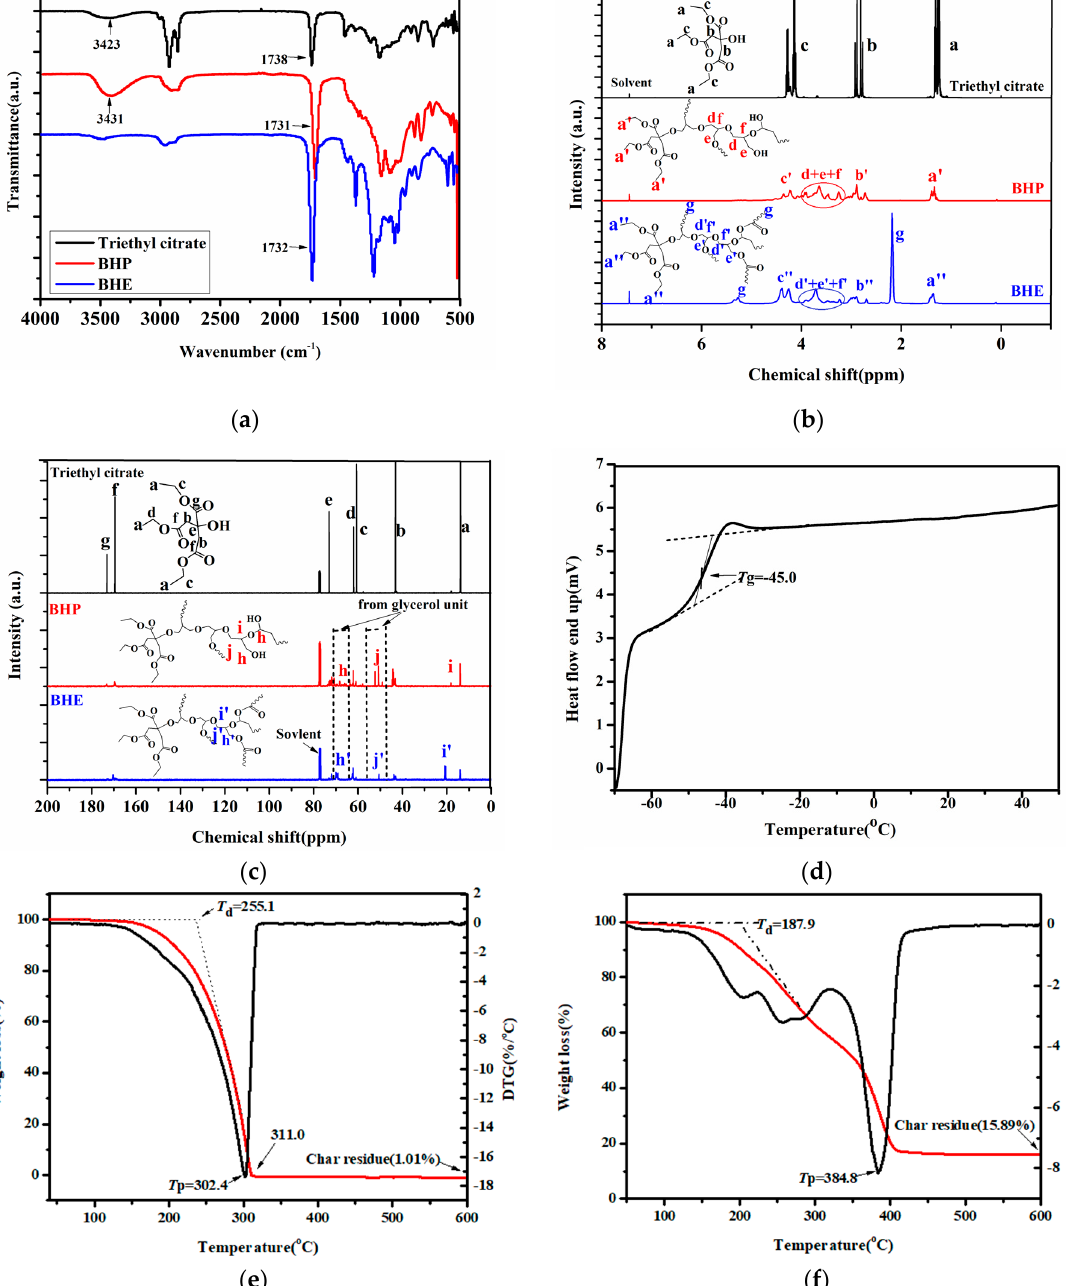
Figure 2. ( a ) FT-IR of triethyl citrate, BHP and BHE; ( b ) 1H NMR of triethyl citrate, BHP and BHE; ( c ) 13C NMR of triethyl citrate, BHP and BHE; ( d ) DSC curves of BHE; ( e ) TGA and DTG curves of DOP; ( f ) TGA and DTG curves of BHE. 00B1 Table 1. Results of acute oral toxicity test.